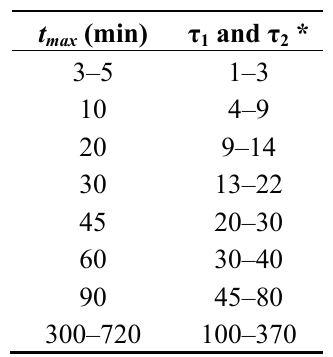
and τ , depending on the value of t 1 2